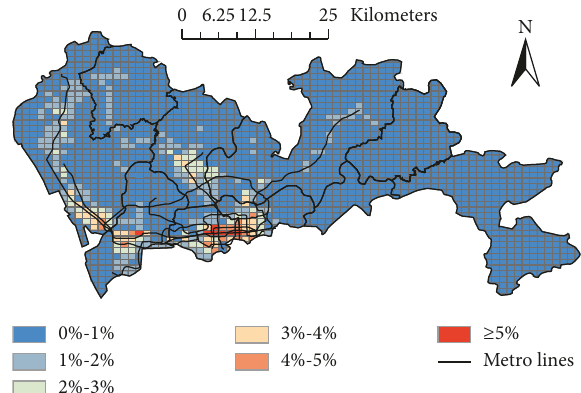
Figure 3: Job accessibility under the threshold C legend labels indicate the percentage of POIs that transit riders can reach from the grid with 45min of the generalized travel